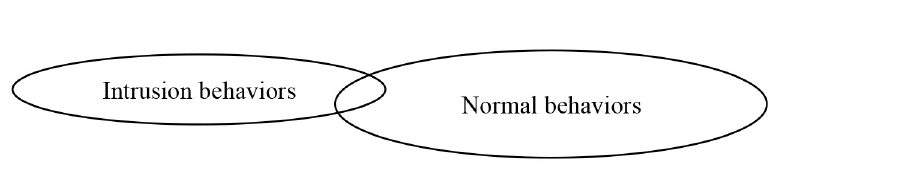
Fig 2. The Overlap between Intrusion Behaviors and Normal